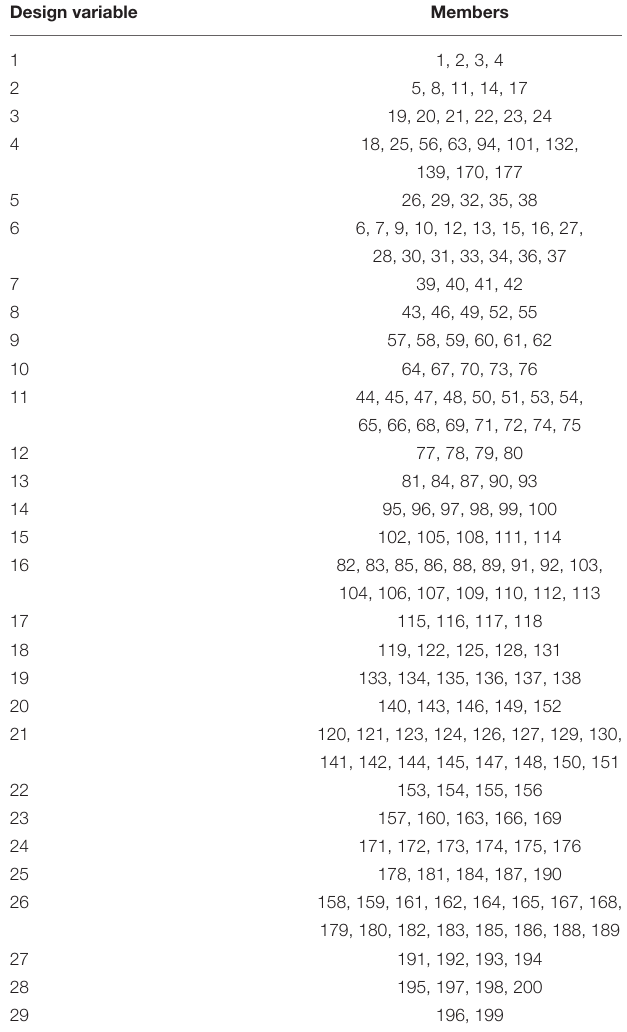
TABLE 8 | 200-bar space truss: Design variable